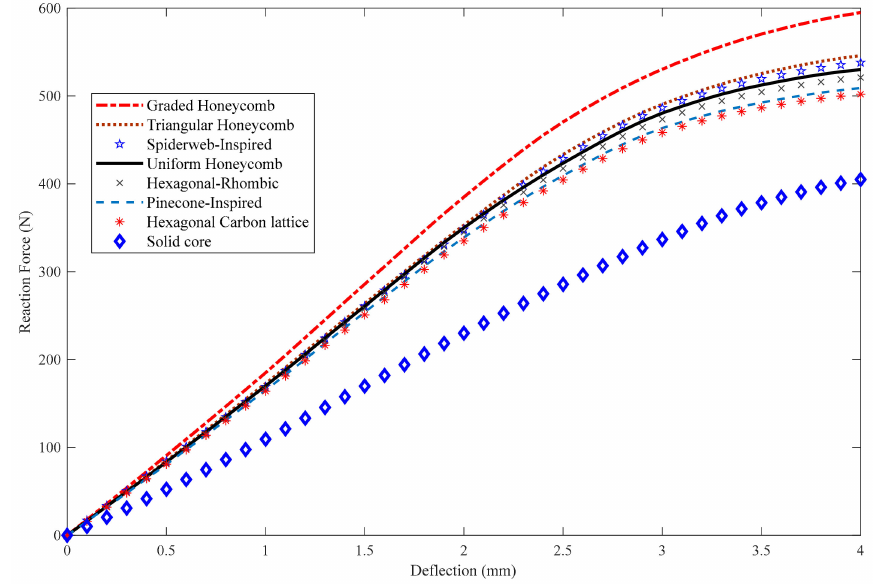
Figure 21. Reaction force–deflection curves for all of the tested